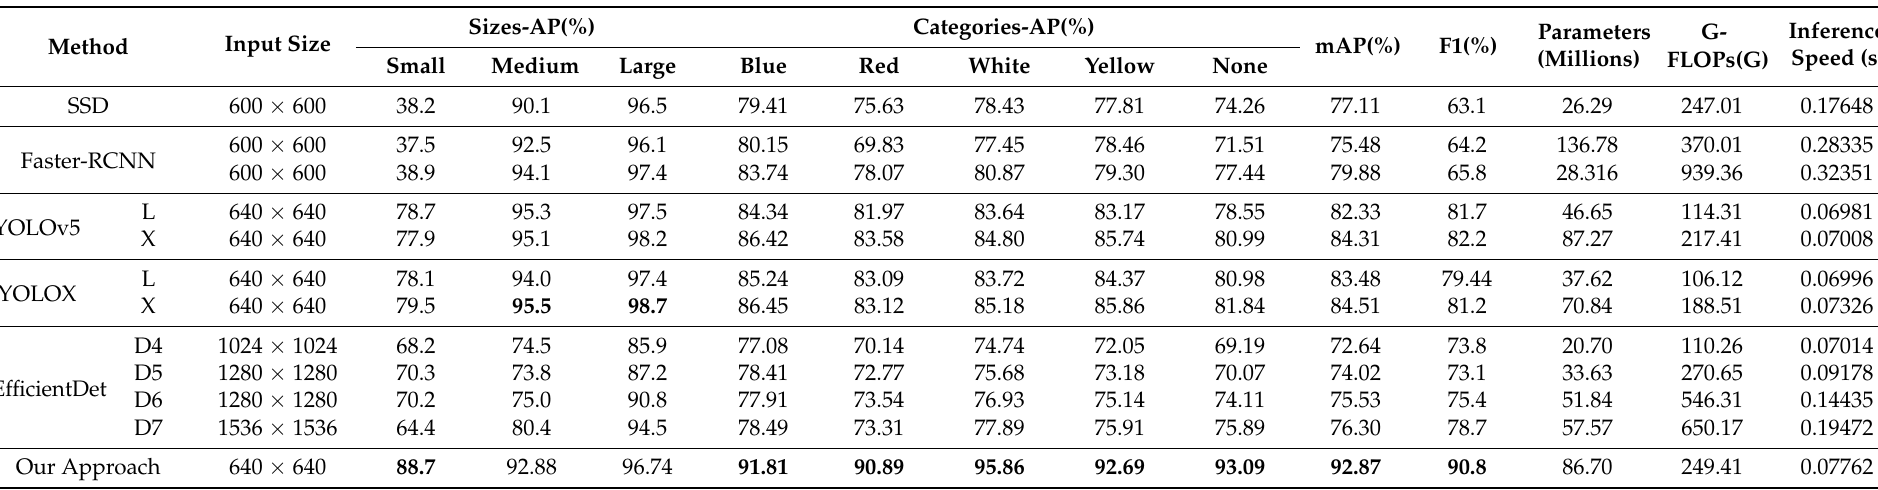
Table 6. Comparison of the proposed method with SSD, Faster-RCNN, YOLO series, and EfficientDet on the same dataset. An Interaction of Union (IoU) threshold of 0.5 is adopted